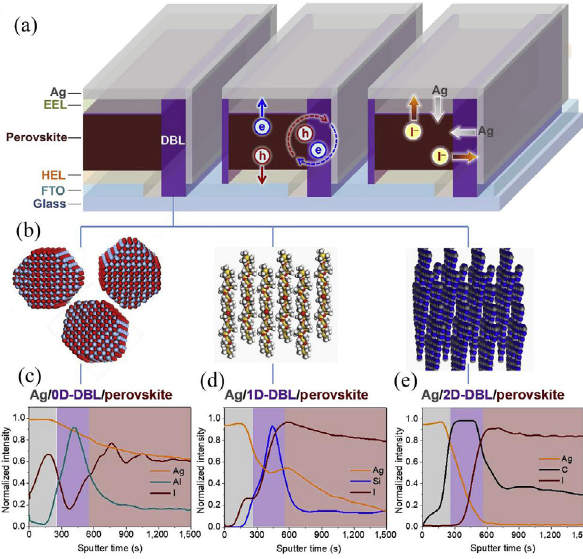
Figure 10 (a) Schematic illustration of diffusion barrier layer (DBL) in PPMs. (b) 0D Al 2 O 3 nanoparticles, 1D PDMS, and 2D C 3 N 4 for DBL. (c)–(e) The depth profiles of diffused iodide and Ag in Ag/0D (1D, 2D)-DBL/perovskite films with aluminum, silicon and carbon signals, respectively. Reproduced with permission from Ref. [81], © Elsevier B.V.